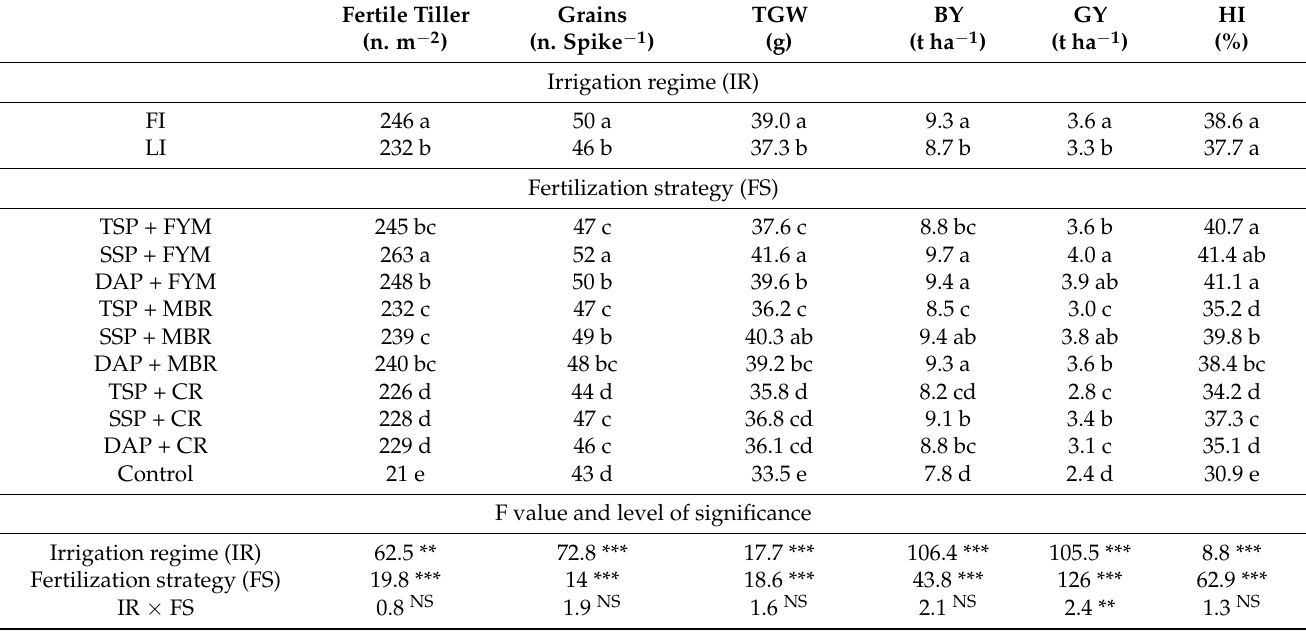
Data are means of 3 replicates. Values belonging to the same characteristic followed by the same letter are not significantly different according to LSD (0.05). FI = Full irrigation; LI = limited irrigation; FYM = farmyard